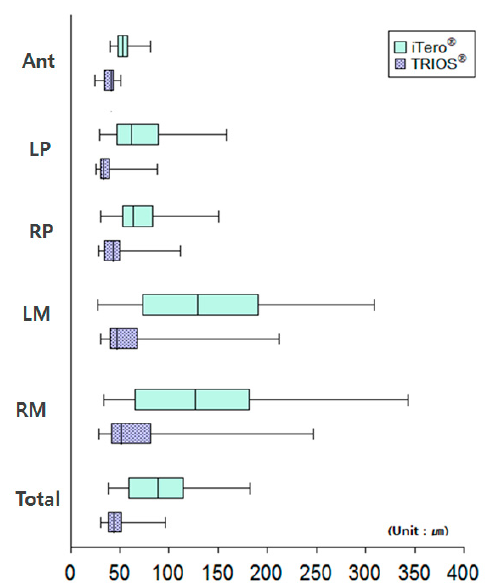
Figure 10. Boxplot showing deviations among sections in the scanned images from iTero ® and Trios ® . For sectioned arch, Ant is the anterior teeth; LP is the left premolars; RP is the right premolars; LM is the left molars; RM is the right molars; Total is the entire arch. The plot shows the median, 25% quartile, 75% quartile and the maximum-minimum range.